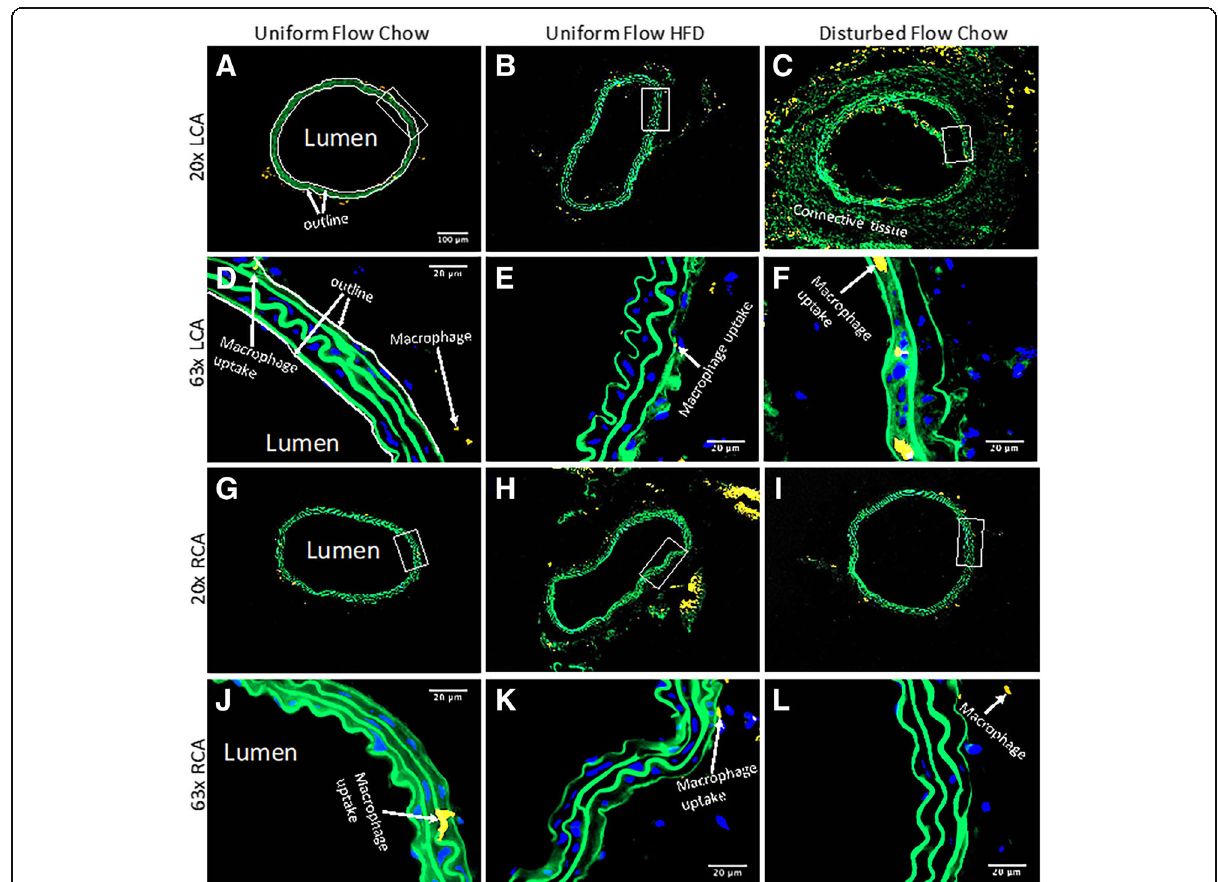
Fig. 5 Visualization of yellow fluorescence tagged CD68-positive inflammatory cells, which infiltrated into carotid artery walls (see green autofluorescence of the elastin wall) to a greater extent in induced disturbed blood flow conditions in comparison to HFD conditions. Blue signifies DAPI, which labels the cell nuclei. From full sets of images like these, percent area fraction of macrophage deposition was calculated in carotid artery walls, which was then normalized by the RCA to its LCA counterpart. Carotid artery walls were marked by outlining the inner and outer diameter of the arterial walls, as demonstrated in ( a and d ). a 20x image of the LCA obtained from an ApoE-KO mouse with a regular chow diet and exposed to uniform blood flow patterns. b 20x image of the LCA from an ApoE-KO mouse fed an HFD and exposed to uniform flow. c 20x image of the LCA from an ApoE-KO mouse on a regular chow diet and exposed to disturbed blood flow due to partial ligation. d 63x image of ( a ) zoomed in on the boxed area, showing a continuous minimal macrophage deposition. e 63x image of ( b ) zoomed in on the boxed area, showing minimal macrophage deposition. f 63x image of ( c ) zoomed in on the boxed area also, showing an increased amount of macrophage deposition in arterial walls. g 20x image of the RCA obtained from an ApoE-KO mouse with a regular chow diet. This RCA was exposed to uniform blood flow while its corresponding LCA was also exposed to uniform blood flow. h 20x image of the RCA from an ApoE-KO mouse on an HFD. This RCA was exposed to uniform blood flow while its corresponding LCA was also exposed to uniform blood flow. Finally, i 20x image of the RCA from an ApoE-KO mouse on a regular chow diet. This RCA was exposed to uniform blood flow while its corresponding LCA was exposed to disturbed blood flow. j 63x image of ( g ) zoomed in on the boxed area, showing minimal macrophage deposition. k 63x image of ( h ) zoomed in on the boxed area, showing minimal macrophage deposition. l 63x image of ( i ) in the designated boxed area also, showing minimal macrophage